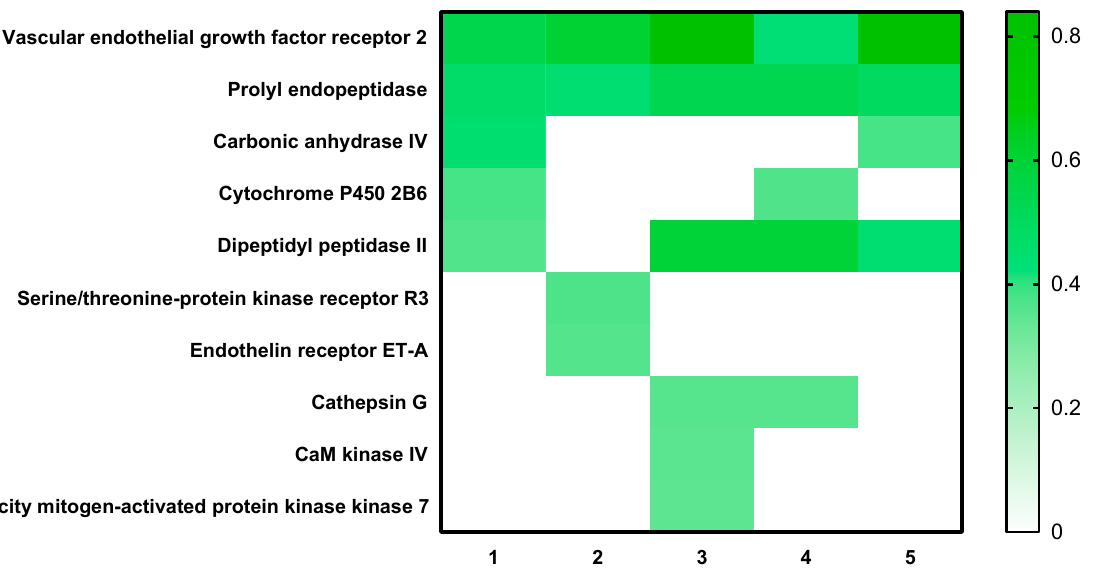
Figure 4. Predicted targets with confidence of ≥ 0.35 for each evaluated compound according to the PASS-Targets server. Numbers below the confidence square indicate the corresponding BCC in Figure